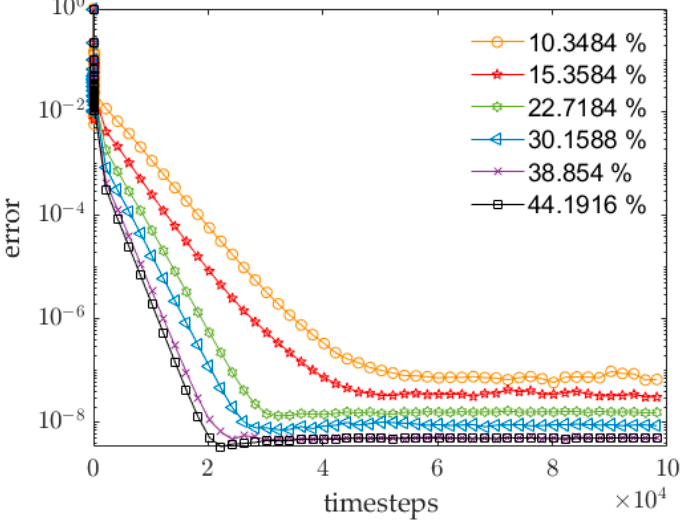
Figure 16. Convergence behavior at different porosity values shown in the legend.